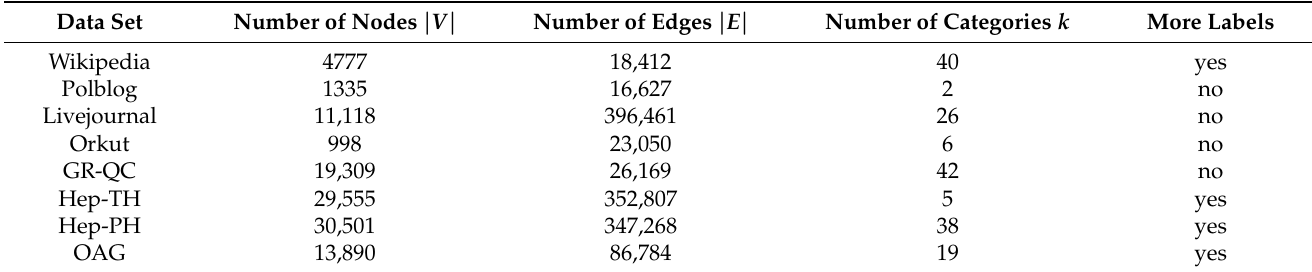
Table 2. Data set network structure